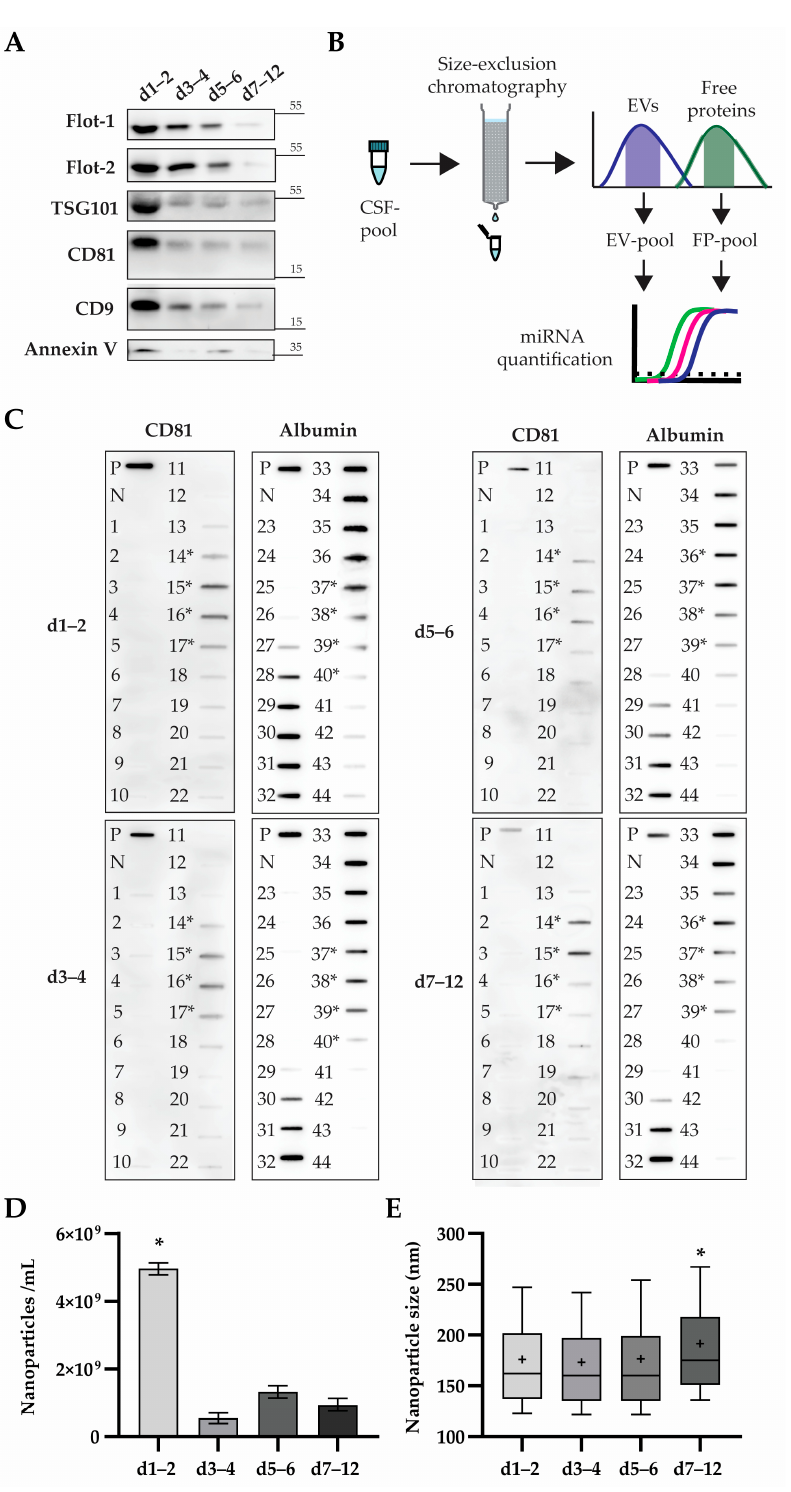
Figure 4. Cerebrospinal fluids (CSFs) after severe traumatic brain injury (sTBI) contain extra- cellular vesicles (EVs) which can be clearly separated from free proteins (FPs) by size exclusion chromatography (SEC). ( A ) Listed CSF pools were analysed by western blot and the immunodetec- tion of depicted proteins with indicated sizes. Representative immunoblots are shown. ( B ) Scheme of major steps in analysing microRNAs (miRNAs) from EVs and FPs obtained by SEC. ( C ) CSF pools were separated by SEC, resulting in fractions applied to nitrocellulose membranes by slot-blot and analysed by the immunodetection of CD81 and albumin. The corresponding CSF pool was lysed and applied as a positive control (PC), while phosphate buffered saline (used as SEC mobile phase) was applied as a negative control (NC). Numbers indicate individual SEC-fractions, and asterisks mark the SEC-fractions pooled for further analyses. ( D ) Nanoparticle concentration was determined in the pool of CD81+ SEC-fractions by tunable resistive pulse sensing (TRPS). Mean values with standard deviations from three measurements performed at two pressure conditions are shown. * p < 0.001 for d1–2 in comparison to all later CSF pools, one-way ANOVA with Tukey’s test for multi- ple comparisons. ( E ) Nanoparticle diameter was determined in a pool of CD81+ positive SEC-frac- tions by TRPS. Each sample was measured three times at two pressure conditions. Values are shown as box plots marking the median (bar), 25th and 75th percentiles (box), the 10th and 90th percentiles (whiskers), and mean value indicated as “+”. * p < 0.001, non-parametric ANOVA (Kruskal-Wallis test) with Dunn’s test for multiple comparisons.